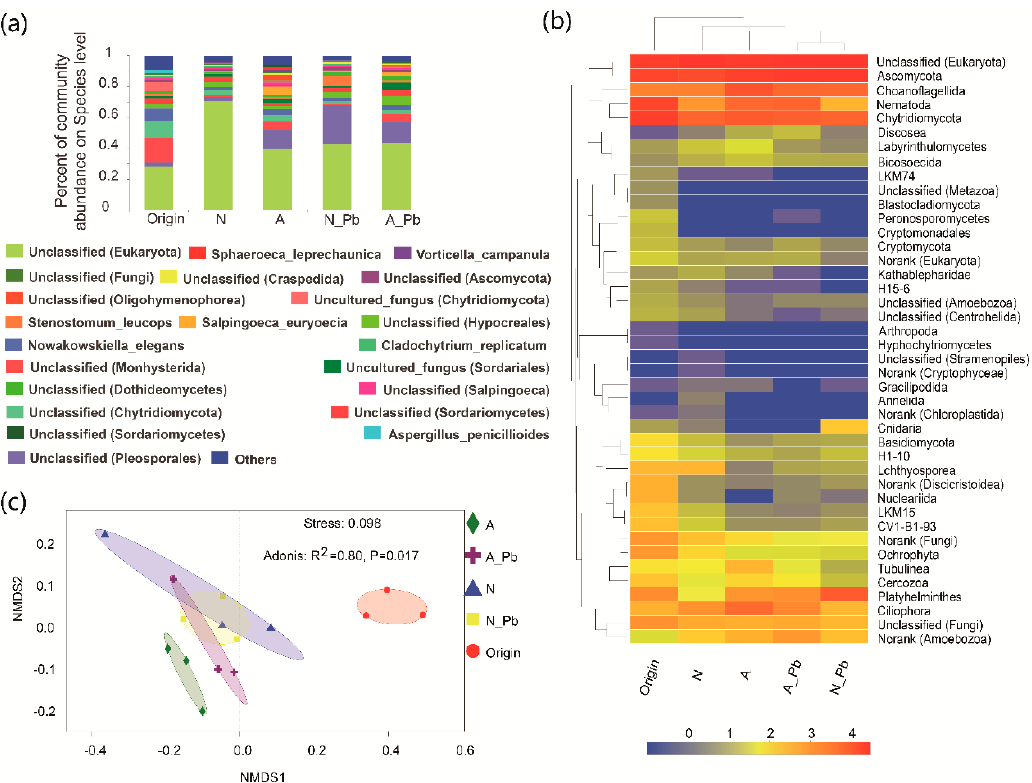
Figure 2. Changes in fungal taxonomic compositions at the species ( a ), and phylum ( b ) levels, and fungal community analysis by nonmetric multidimensional scaling ( c ), before and after exposure to ALAN and/or Pb. The color scale indicates the relative abundance of fungal phylum in log 2 scale, with red representing a high relative abundance and blue, a low relative abundance. Treatment abbreviations are defined in Figure 1.